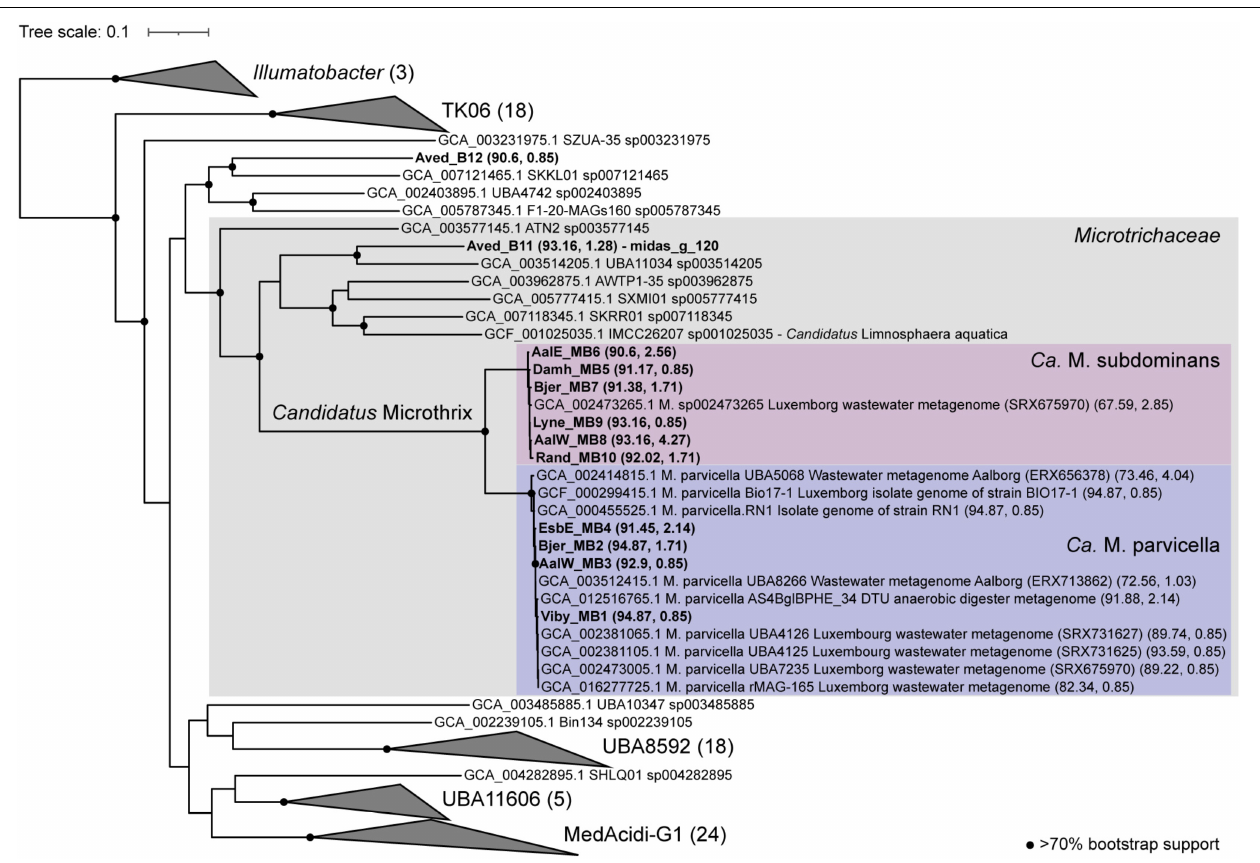
FIGURE 7 | Phylogenetic maximum likelihood genome tree of the Ca. Microthrix MAGs and related genomes using the concatenated alignment of 120 single copy proteins created by GTDB-Tk and the GTDB RefSeq release 95. Three Illumatobacter isolate genomes were used as the outgroup. Bootstrap support > 70% is shown by the solid black